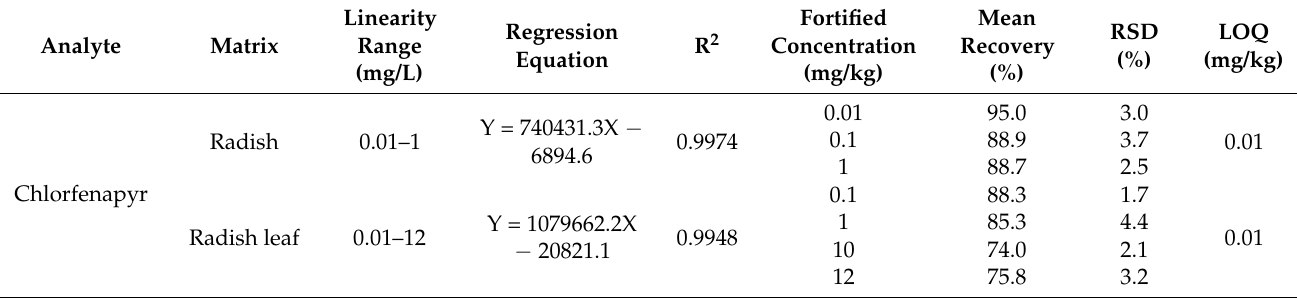
Table 1. Linear range, regression equation, correlation coefficient (R 2 ), fortified recovery, relative standard deviation (RSD) and limit of quantitation (LOD) of chlorfenapyr and tralopyril in radish and radish